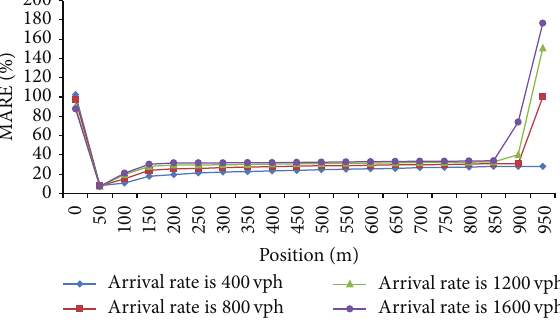
Figure 4: Estimate error versus different sensor locations.